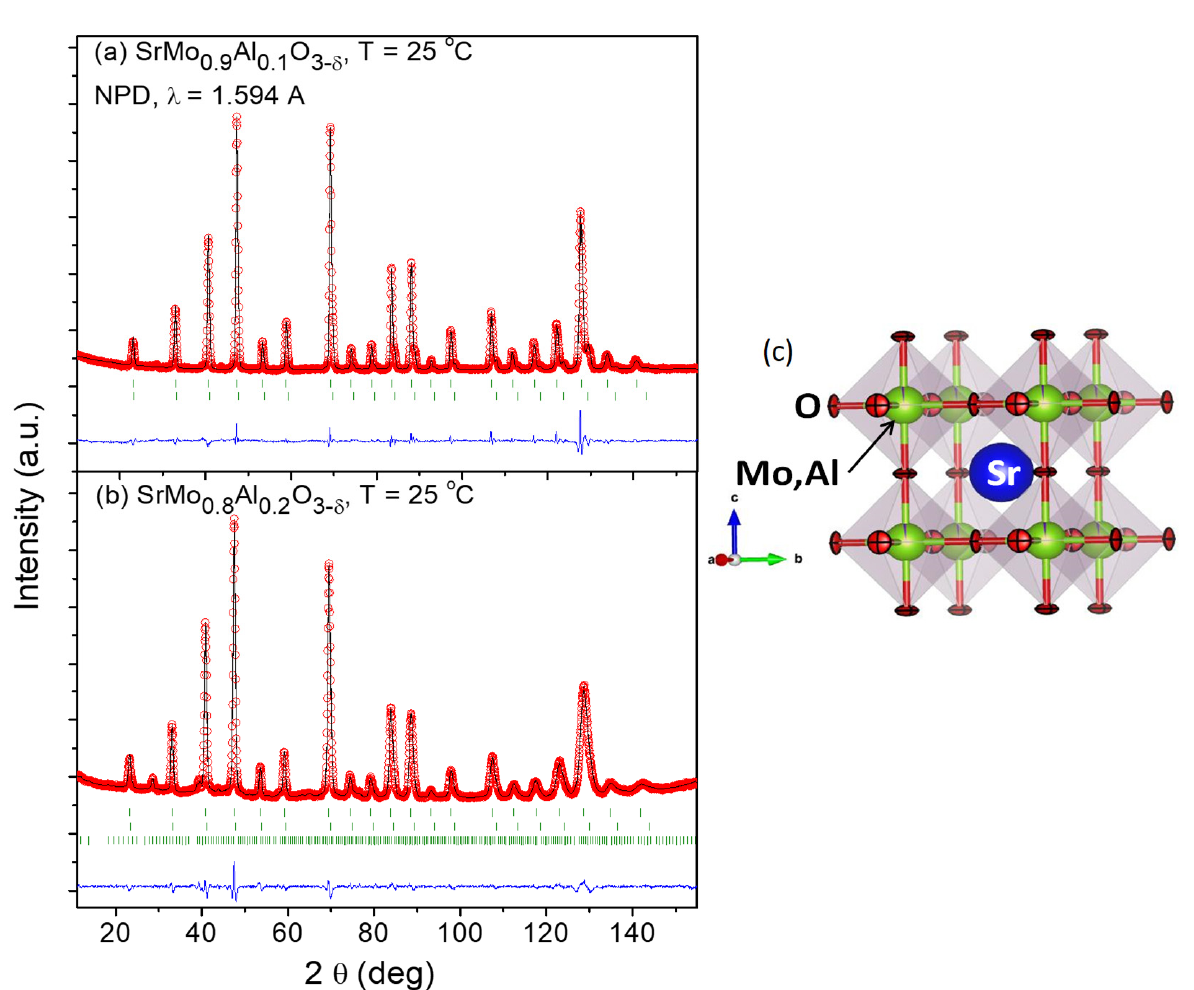
Figure 1. The XRD patterns with CuK α radiation for SrMo 1 − x Al x O 3 − δ (x = 0, 0.1 and 0.2). The aster- isks correspond to a tiny impurity of Sr 8(Al 12 O 24 )(MoO 4 ) 2 with sodalite structure (space group I 4 1 / acd ).